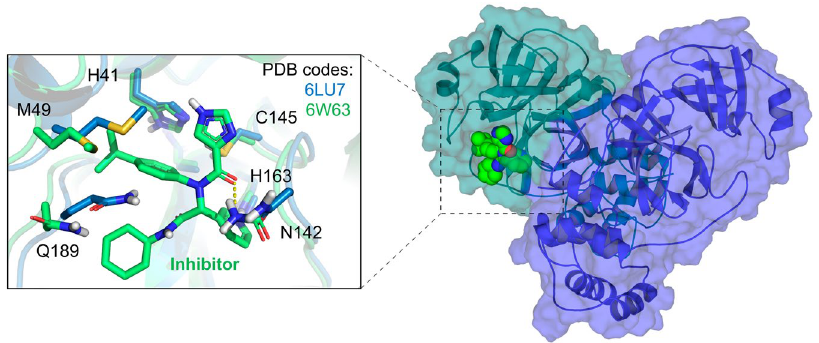
Figure 2. Conformations of the Mpro provided at the DockThor-VS web server as representative structures of the protein flexibility. The protein complexed structure with a covalent inhibitor is coloured blue (PDB